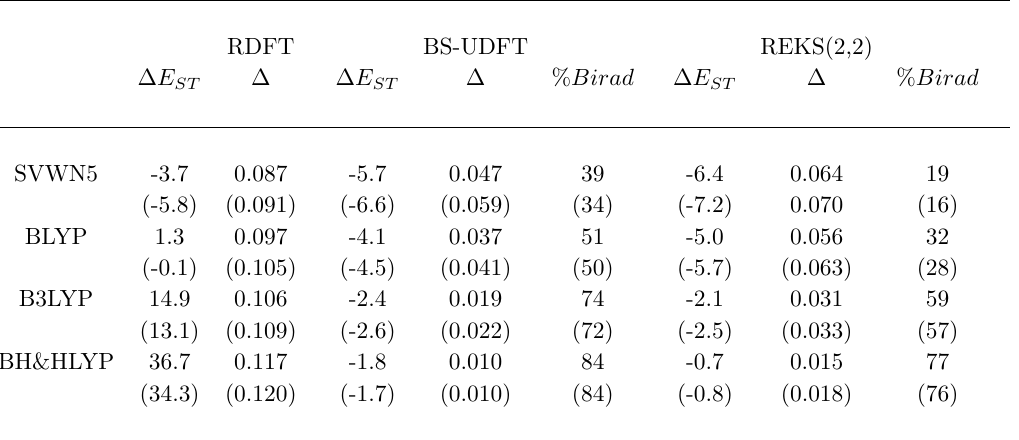
Table 1. Description of p-benzyne (1) at different levels of DFT.